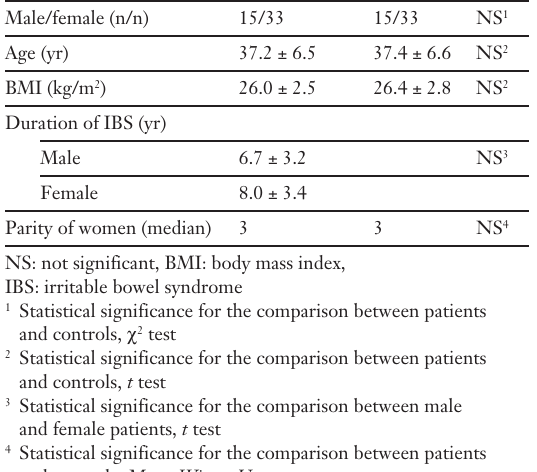
The characteristic features of study and control groups (mean ±